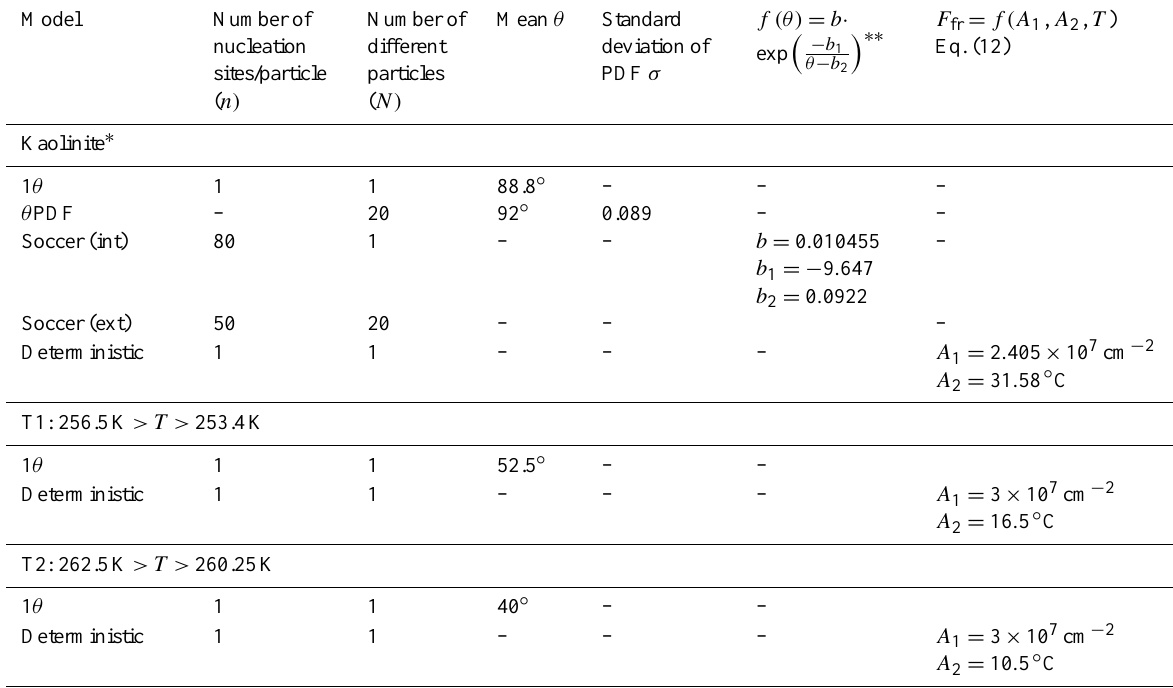
Table 1. Parameters to describe contact angle ( θ ) distributions for the different nucleation schemes as used in the box and parcel models. Note for both the box and the parcel models the same θ selections were